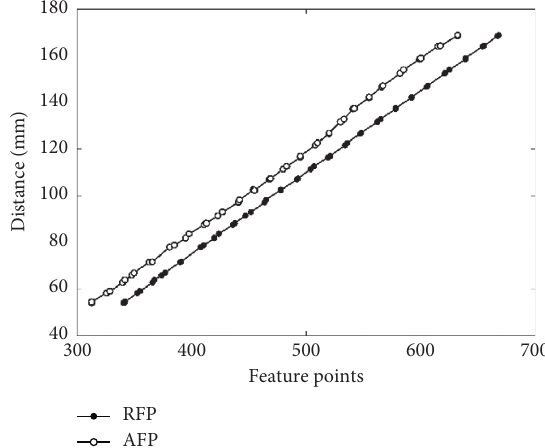
Figure 7: AFP-distance and RFP-distance relationship.